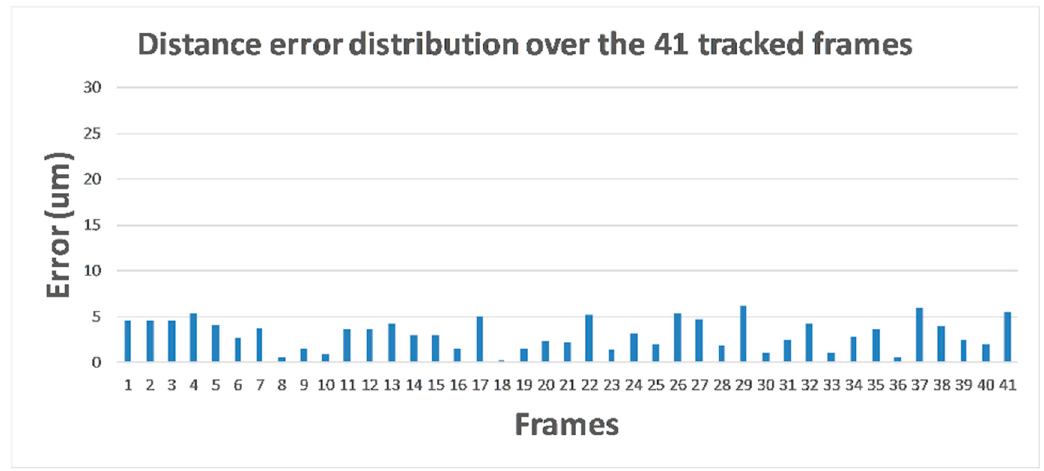
Figure 20. Distance error distribution over the 41 tracked frames.